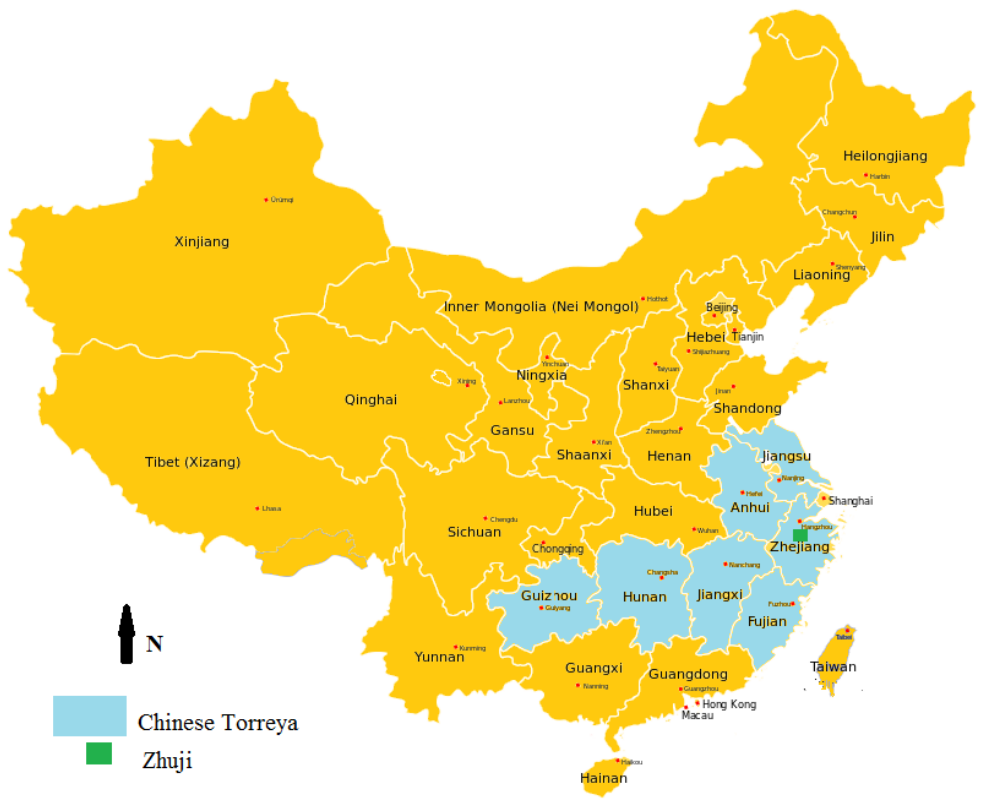
Figure 1. The distribution area of Chinese Torreya plantations in the provinces of China.